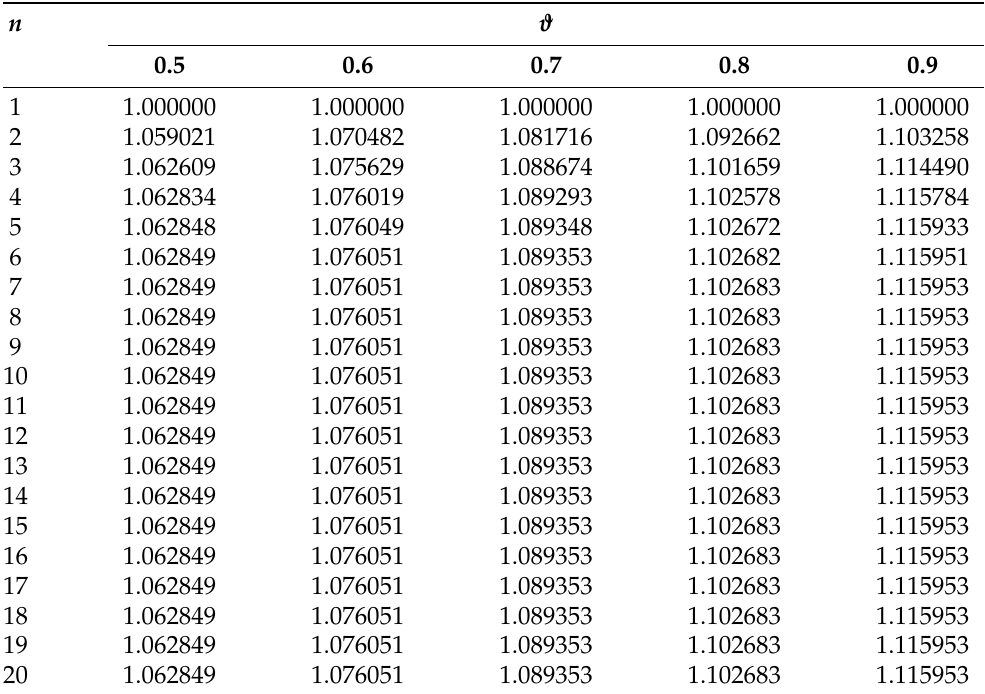
Table 2. Numerical results of z n + 1 ( ϑ ) for n = 1,2, . . . ,20 and ϑ = 0.5, 0.6, 0.7, 0.8, 0.9 by using (21) in Example 1.